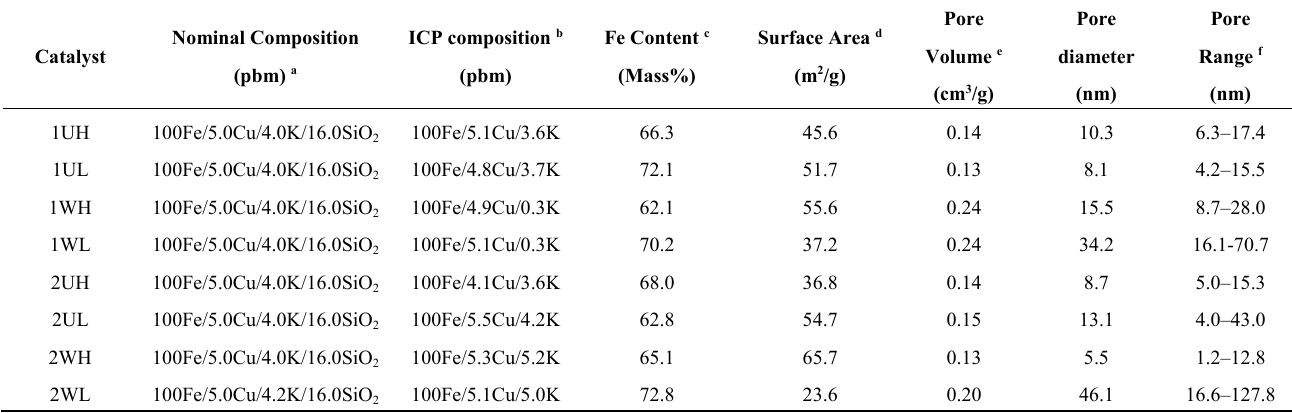
Table 1. Compositions and pore properties of Fe